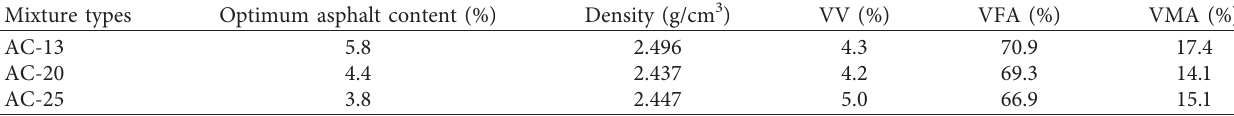
Table 6: Marshall design results for different asphalt mixtures.